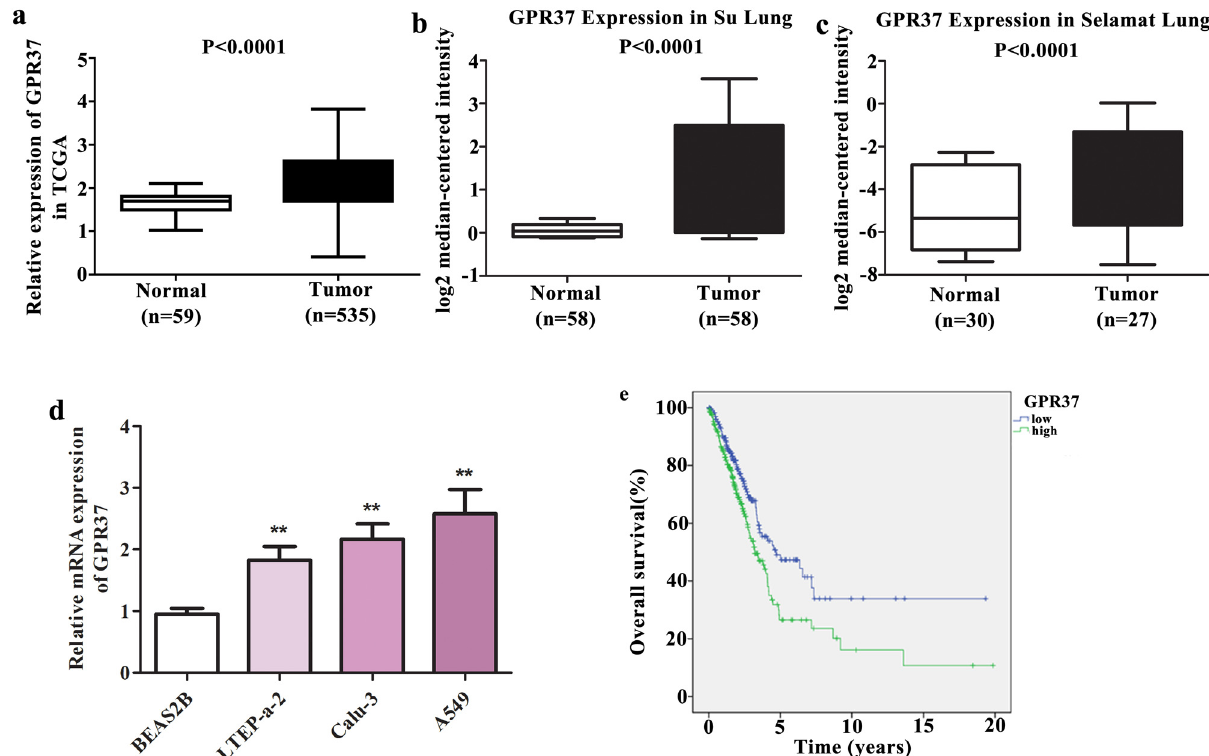
Figure 1: GPR37 was expressed at high levels in LUAD and was related to poor outcomes. The di ff erential expression of GPR37 in LUAD patients and healthy control was analyzed based on the ( a ) TCGA database as well as Oncomine databases, ( b ) Su Lung, and ( c ) Selamat Lung. P < 0.0001. qRT - PCR was performed to measure ( d ) the expression of GPR37 in LUAD cell lines A549, Calu - 3, and LTEP - a - 2. ** P < 0.01 vs control group. ( e ) Kaplan – Meier analysis was used to draw a conclusion between GPR37 expression and the survival rate in LUAD patients. P <